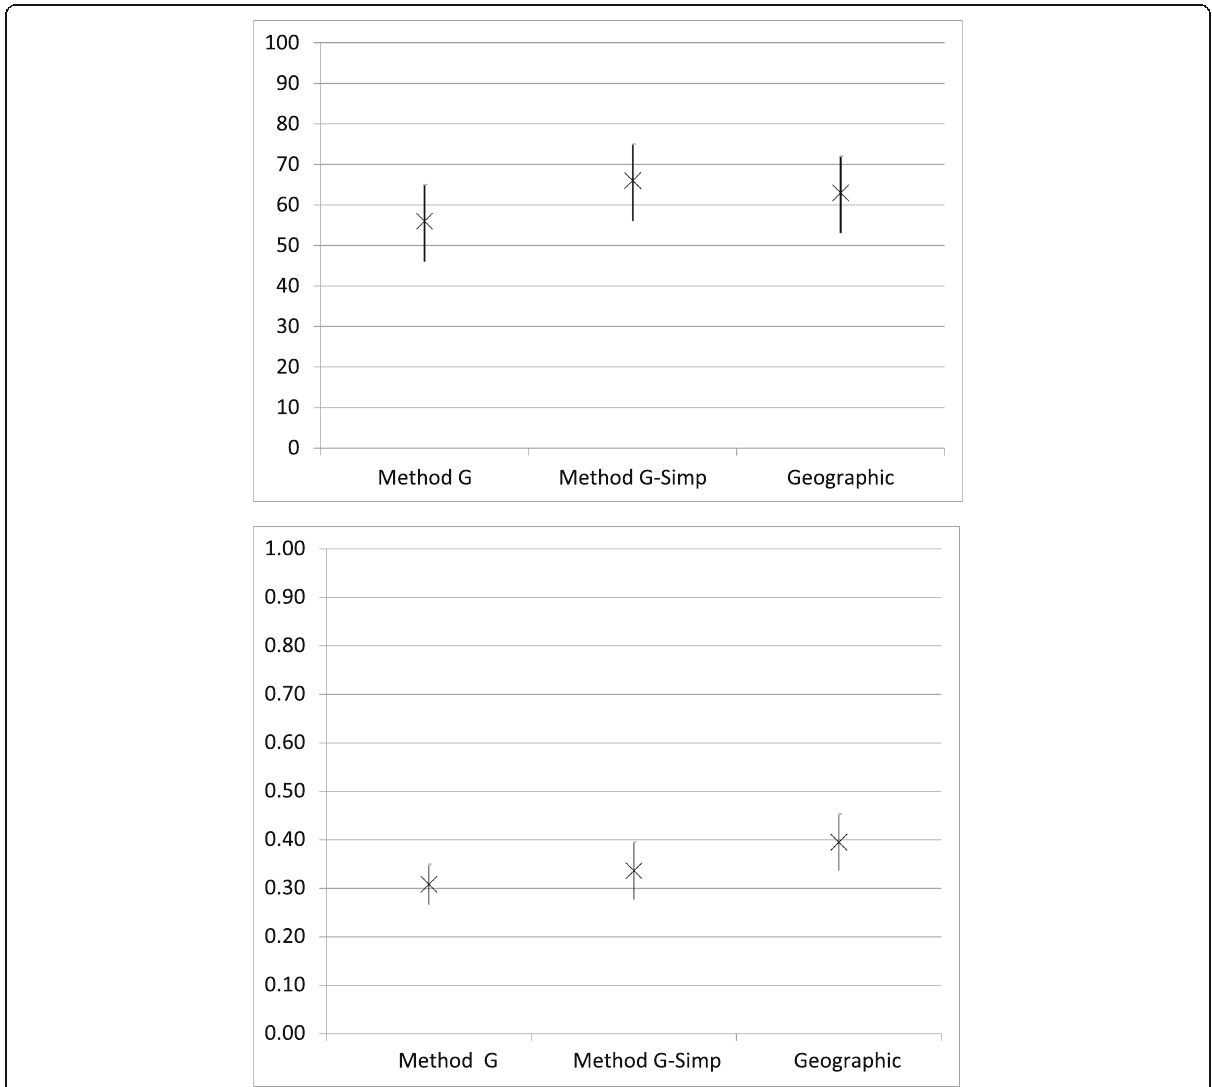
Fig. 5 Acetabular Chondral Lesion Accuracy (top) and Interobserver reliability (bottom). X=accuracy (%) or kappa coefficient with 95% confidence